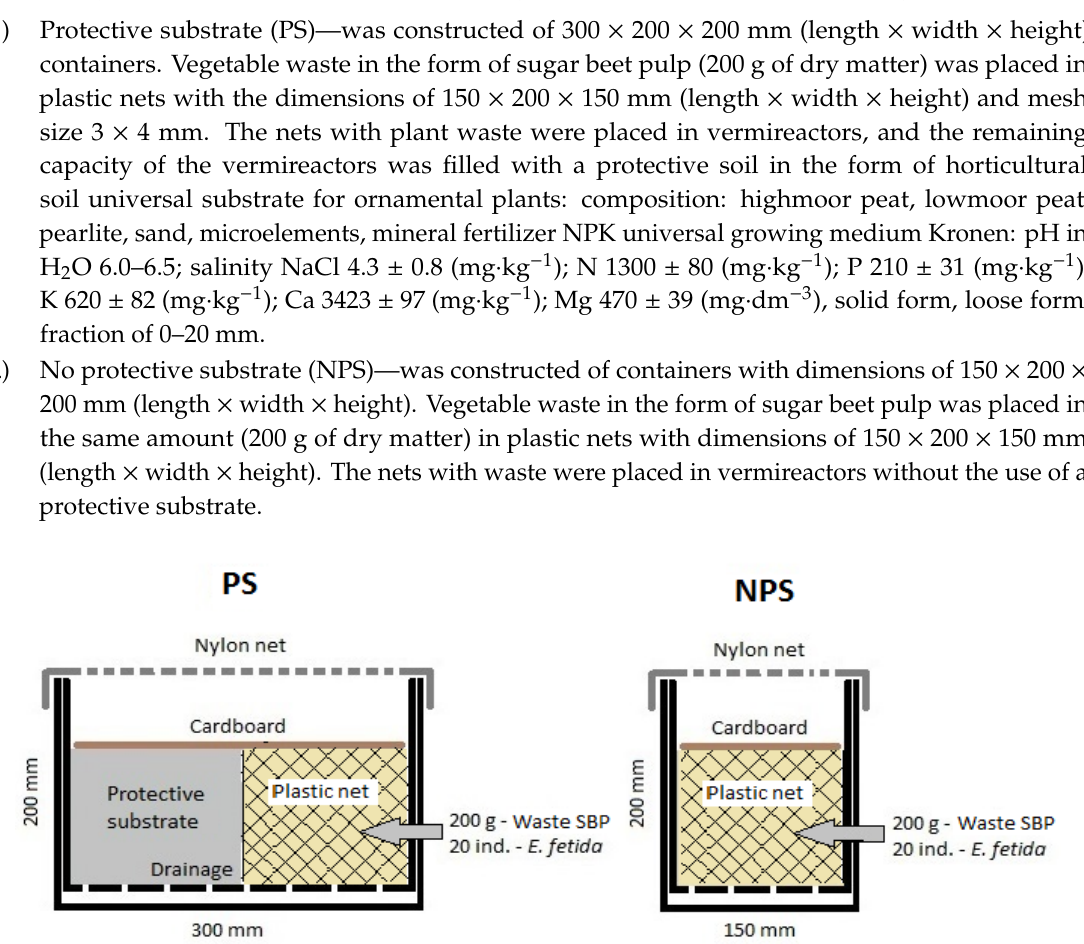
Figure 1. Scheme of the vermireactors (PS—protective substrate; NPS—no protective substrate; Waste SBP—sugar beet pulp).